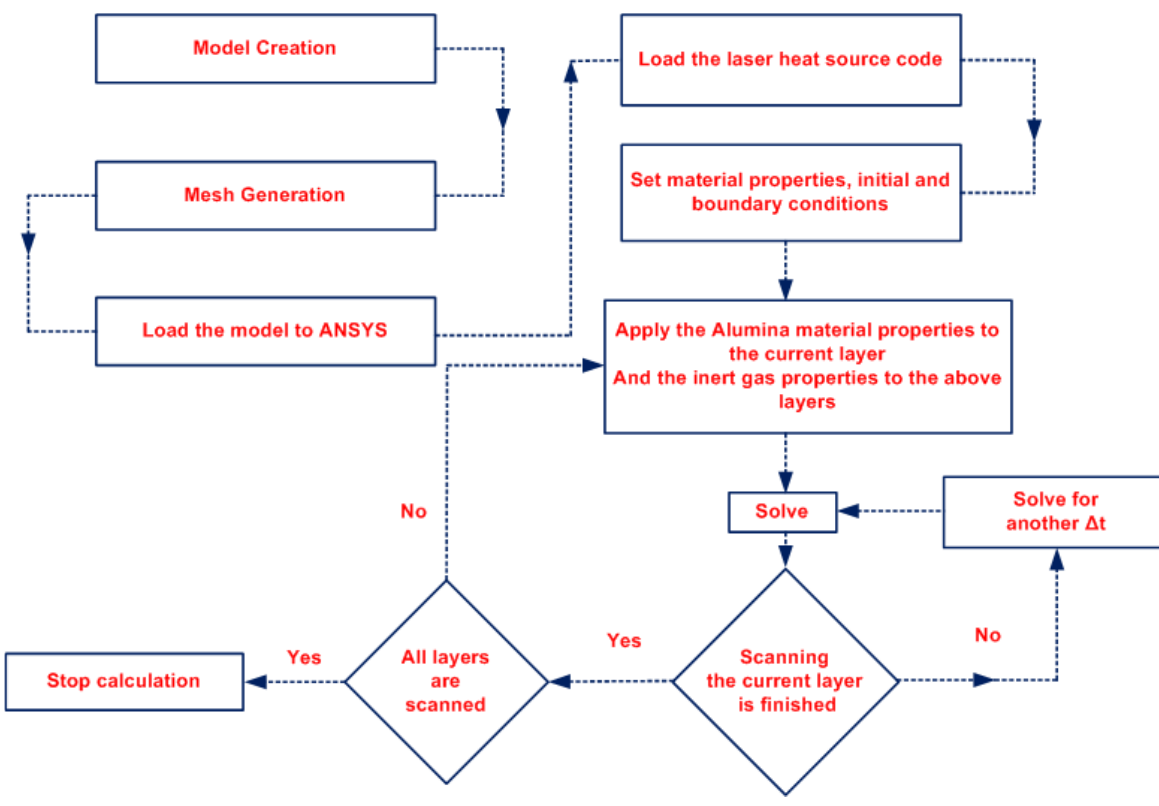
Figure 4. The numerical model solution steps.